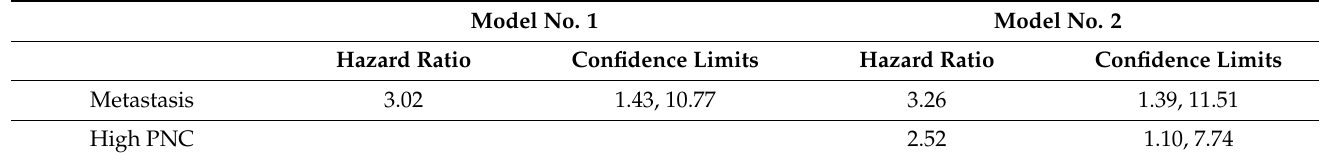
Table 3. Multivariate model, Cox regression for disease-free survival.